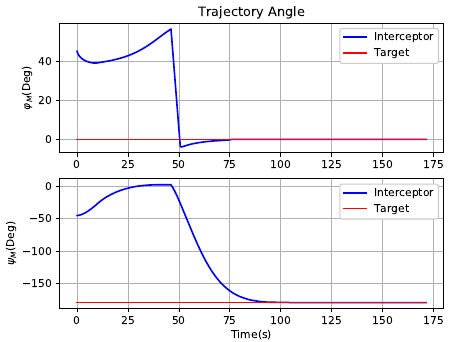
Figure 11. Trajectory angle of interceptor (target non-maneuvering).